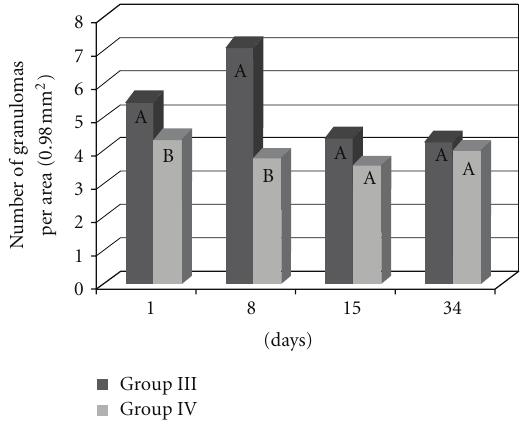
Figure 11: The number of granulomas in the liver of the mice that were previously infected with the S. mansoni BH strain and then inoculated 8 weeks later with eggs from the S. mansoni BH (Group III) or SJ (Group IV) strains. The mice were euthanized 1, 8, 15, or 34 days after the inoculation with the eggs. For each time point, the means depicted with the same letter do not di ff er significantly ( α = 0 .